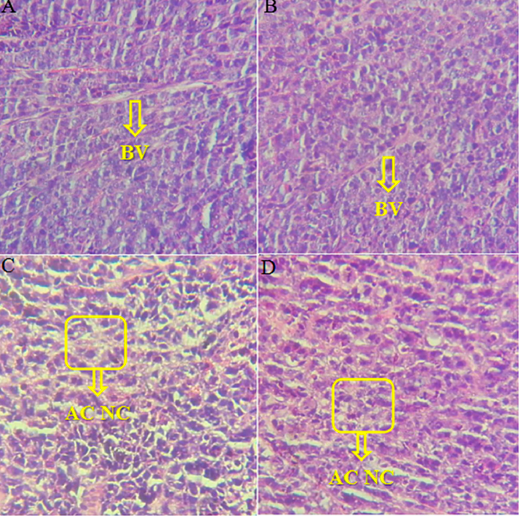
Figure 18. Hematoxylin and eosin (HE) staining of tumor tissue. ( A ) NS group, ( B ) naked VEGF-siRNA group, ( C ) GRcR/ VEGF-siRNA group, and ( D ) DOX group. BV: blood vessels; AC: apoptotic cells; NC: necrotic cells. (Original magnification: 40×)